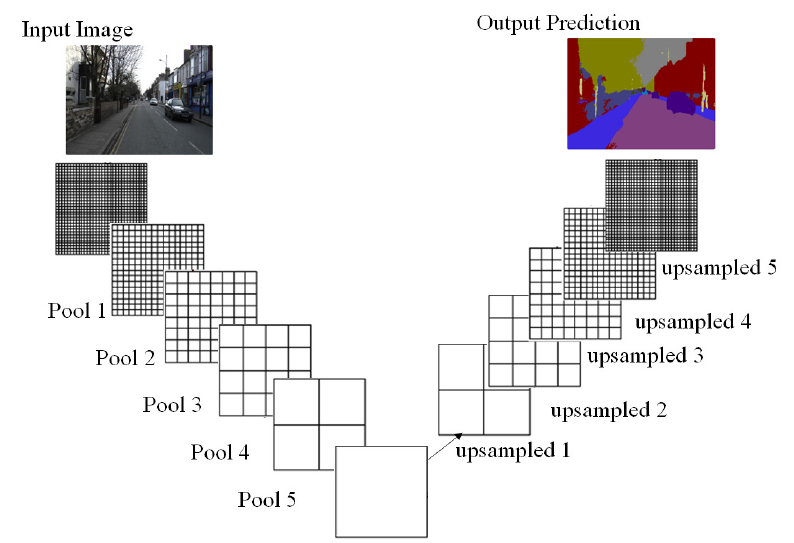
Figure 2. Encoder–decoder architecture for semantic